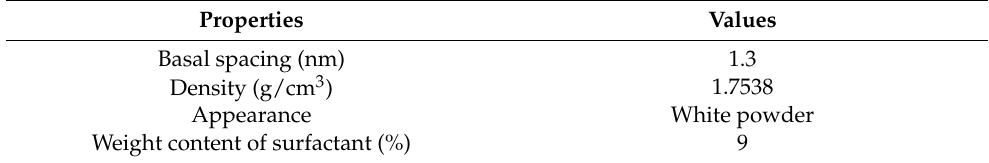
Table 2. Physical properties of